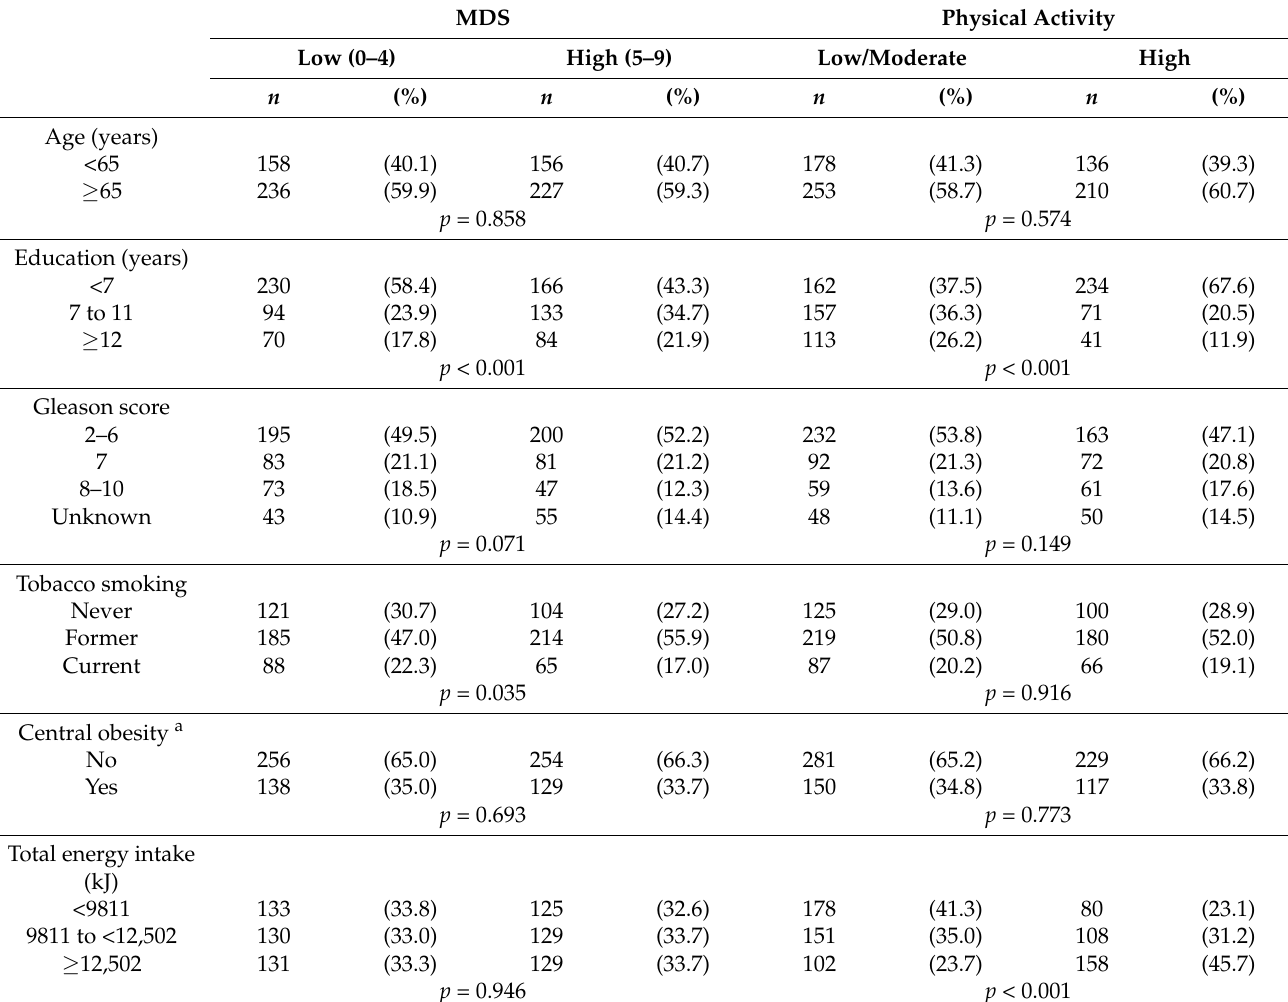
Table 1. Distribution of 777 men diagnosed with prostate cancer, according to baseline characteristics, Mediterranean Diet Score (MDS) and physical activity. Italy,